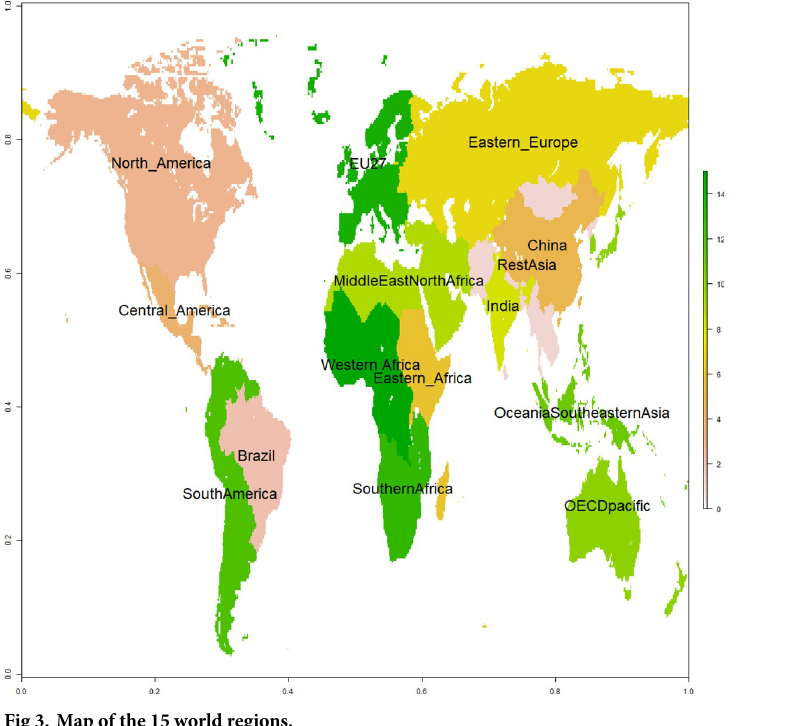
Fig 3. Map of the 15 world